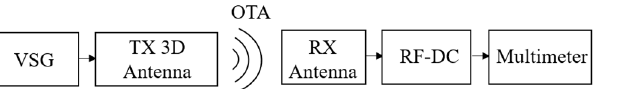
Figure 14. Block diagram of the measurement setup to characterize the WPT system.